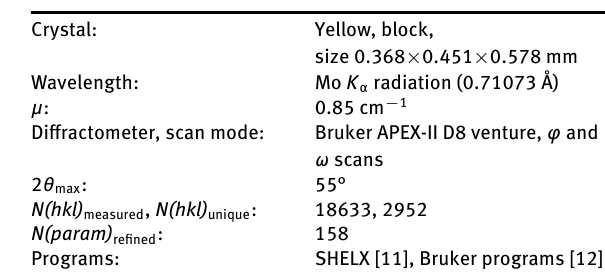
Table 1: Data collection and handling.